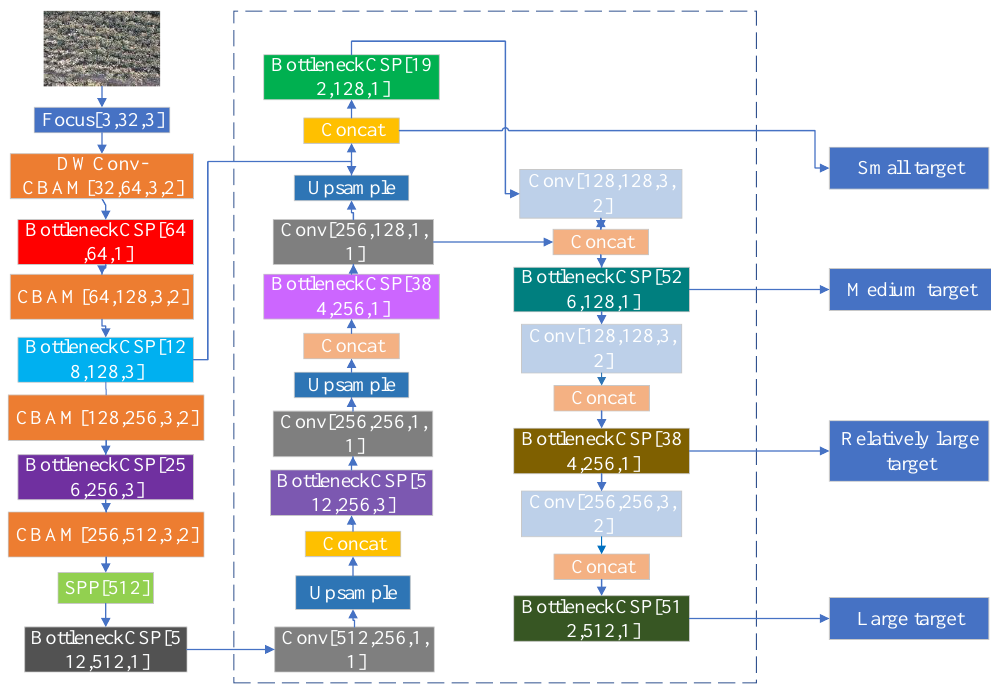
Figure 8. Improved YOLOv5x network structure